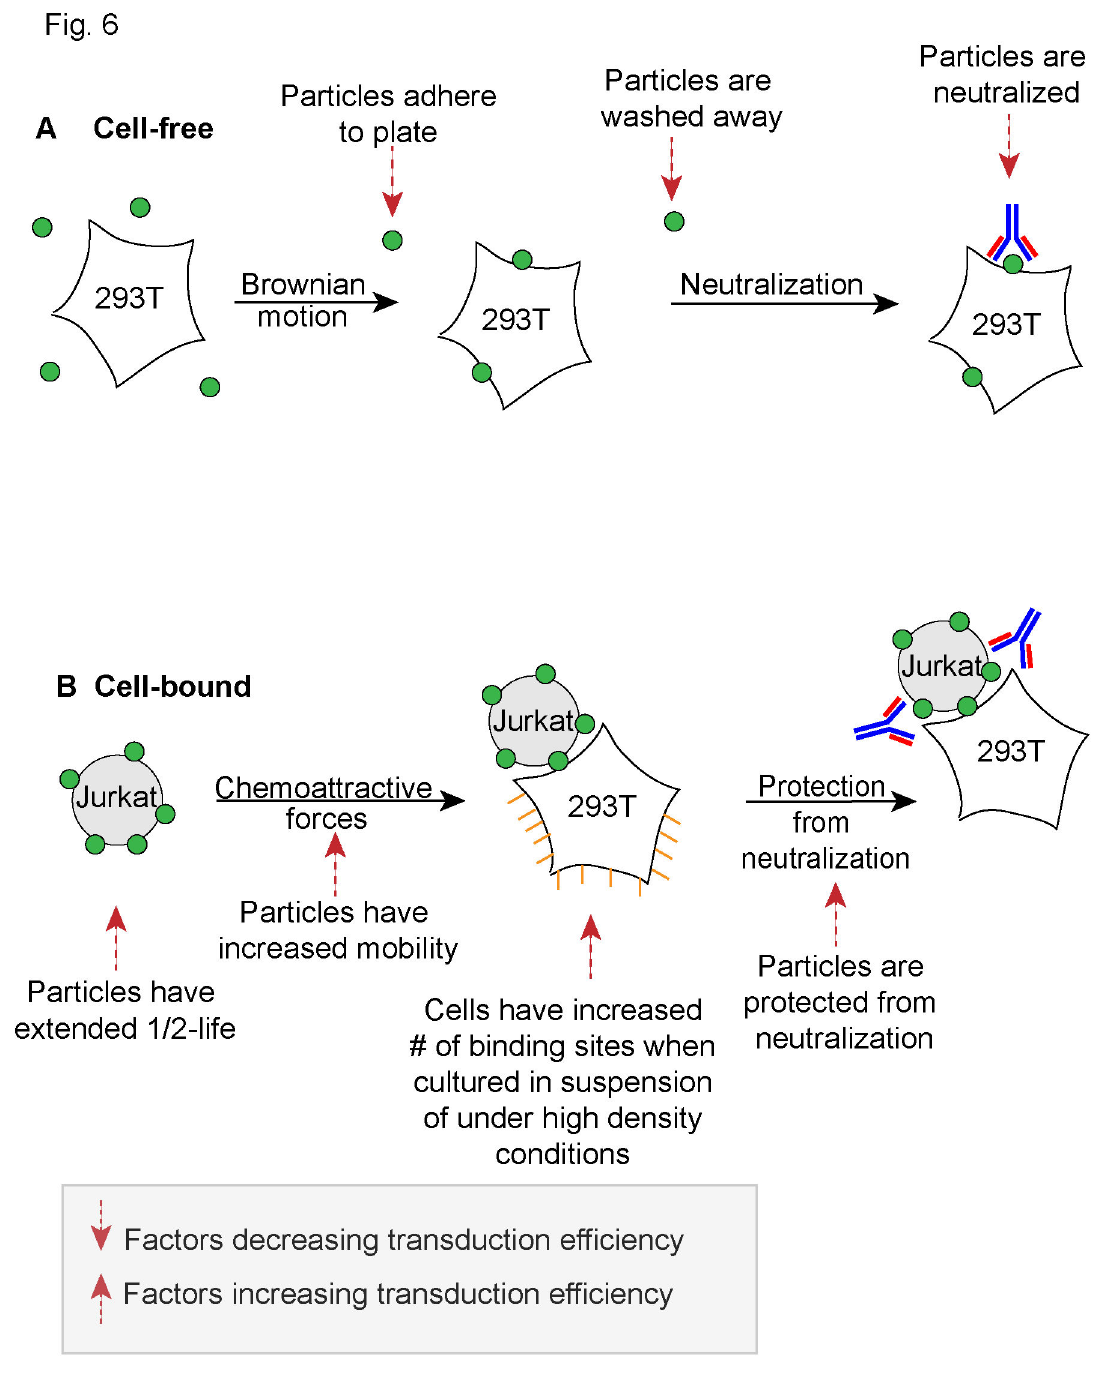
Figure 6. Lentivector cell-cell transmission. ( A ) Cell-free transduction. Several factors are shown that negatively impact transduction efficiency. ( B ) Cell-bound transduction. Several factors are shown that improve transduction efficiency.